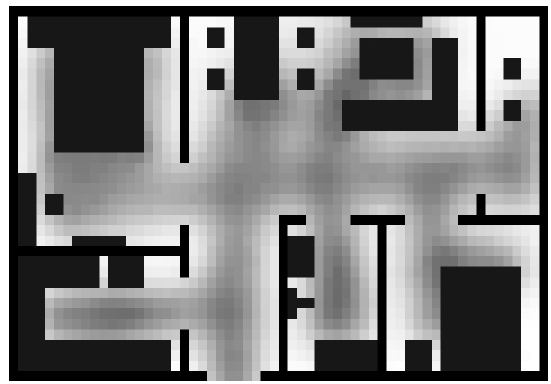
Figure 6. The grid-based grey image of accessible map.